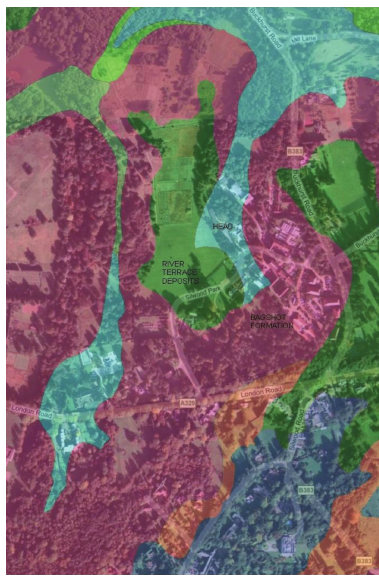
Figure 5: Map of three testing sites at Silwood Park.